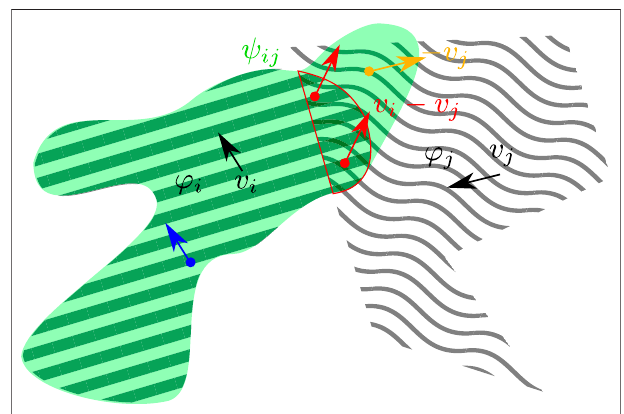
FIGURE 4 | Illustration of Eq. 15 with b j (cid:2) − 1. The two considered features φ i (diagonal lines), φ j (wavy lines) translate over the frame spatial supportwithuniformvelocities v i , v j .Thegreenarearepresentswhere ψ ij ison, while the red border identi fi es the region where φ i and φ j overlap. On the overlapping region the velocity fi elds of the two features are both present and here the affordance fi eld ψ ij ( x , t ) is constrained to be consistent along the direction v i − v j (red arrows). Outside and on the left of the red border, the consistency term in Eq. 15 essentially collapses to the feature identity constraint Eq. 9 de fi ned by the invariance motion property with respect to v i (blue arrow). Finally, in those region where v i (cid:2) 0, motion consistency of ψ ij is required along − v j (orange arrow).